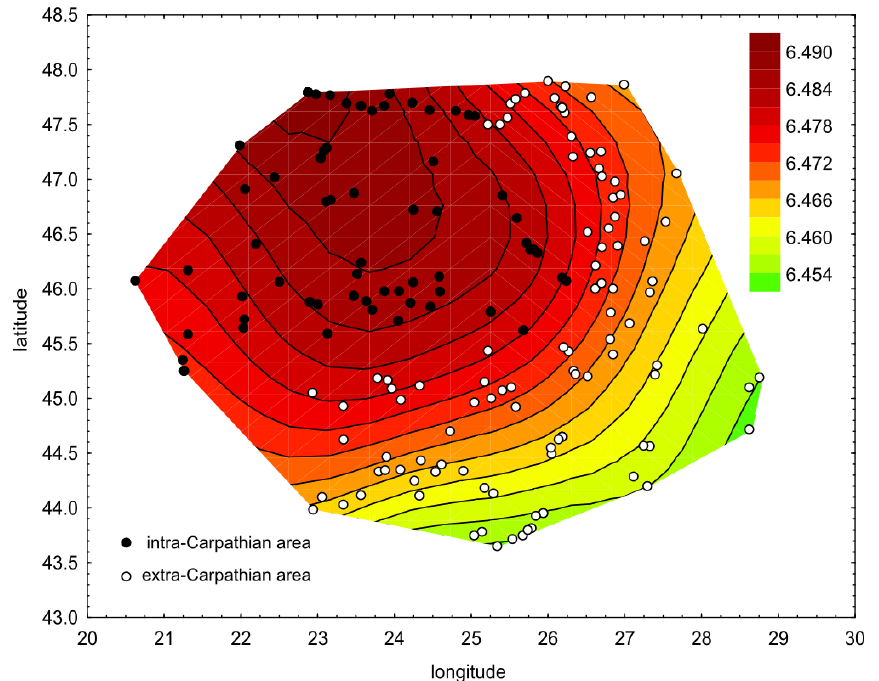
Figure 6. Wing size interpolated over the longitude and latitude of the study area. The colours from green to red represent a natural logarithm of centroid size.